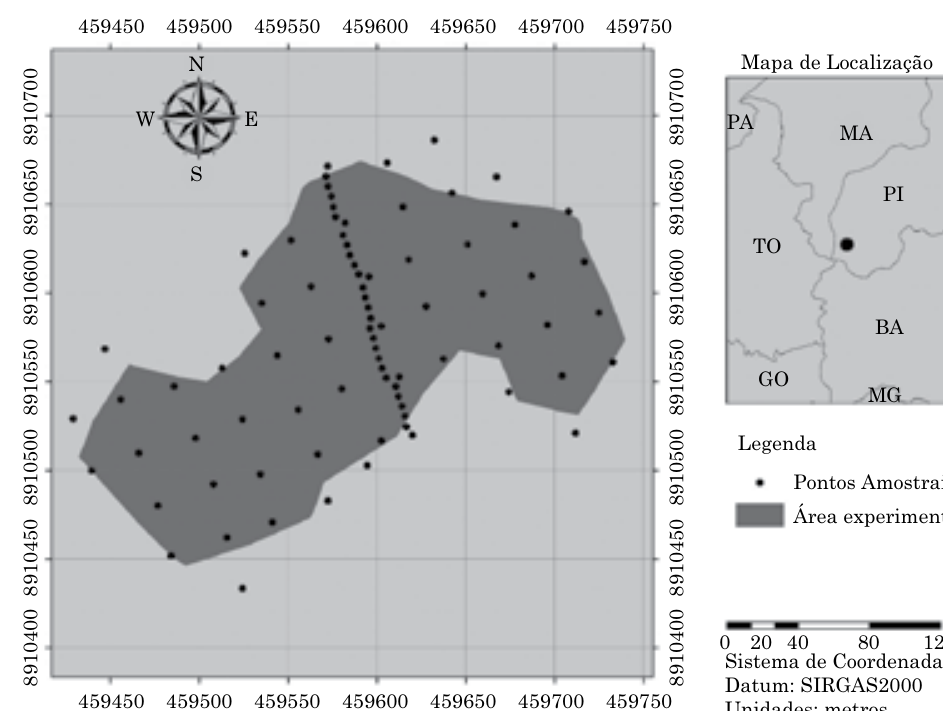
Figura 1. distribuição da malha amostral e localização do município de gilbués,